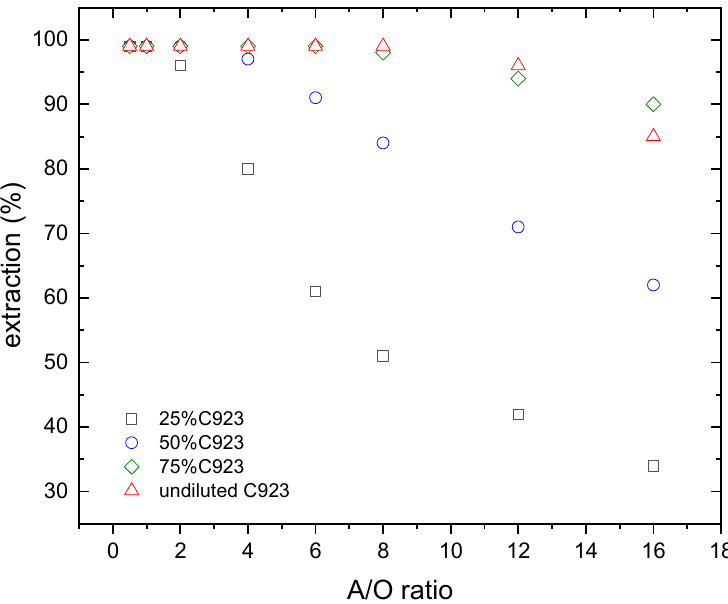
Figure 4. Lanthanum extraction at various Cyanex 923 concentrations. Temperature: 20 °C.